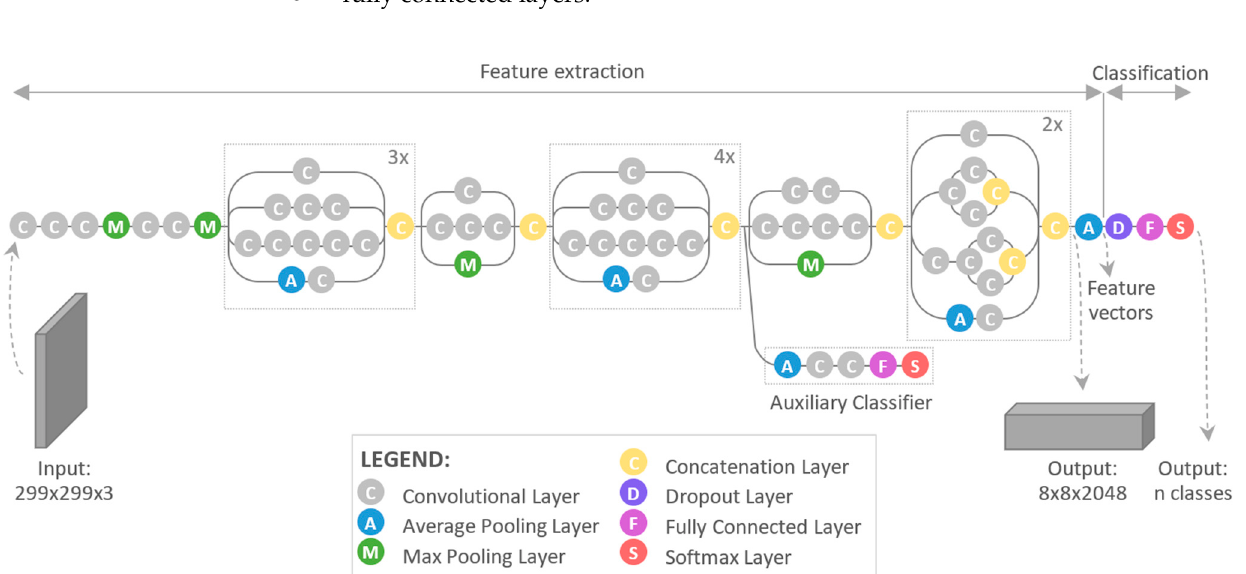
Figure 9. Last layers of CNN that are trained for a specific case. The Python libraries Keras and TensorFlow were used for model implementation. TensorFlow is a software framework developed by the Google Brain team. In 2019, they released version 2.0 with integrated Keras, which is a high-level API, written in Python. 2.5. Criteria for the Model Evaluation Criteria for evaluating the performance of the classification were calculated using a confusion matrix, which shows the classification of images into classes according to the real situation and according to the model prediction. The matrix has the correct values written in columns and the values specified by the model in the rows (or vice versa). The correct predictions of the classifier lie on the diagonal of the matrix, and the incorrect ones outside the diagonal.